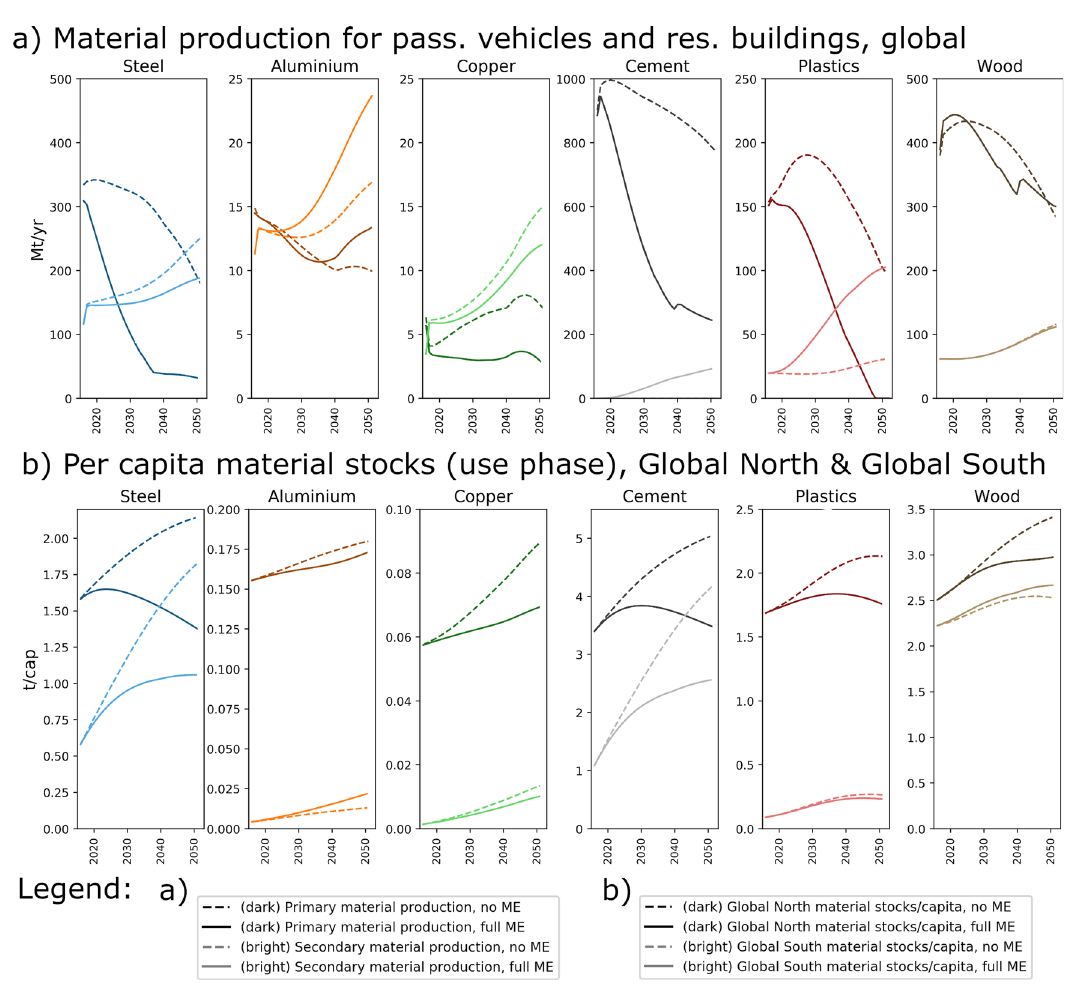
Fig. 4 Impact of material ef fi ciency on material production. a Global material production 2016 – 2050 (primary = from virgin resources, secondary = from post-consumer scrap) for six major materials in SSP1 and a 2 °C policy mix, for passenger vehicles and residential buildings, and for scenarios with no and those with full material ef fi ciency (ME). b Per-capita in-use stocks (2016 – 2050) of materials in passenger vehicles and residential buildings, Global North, and Global South average. The unit for part a is megatons per year (Mt/yr) and for part b it is ton per capita